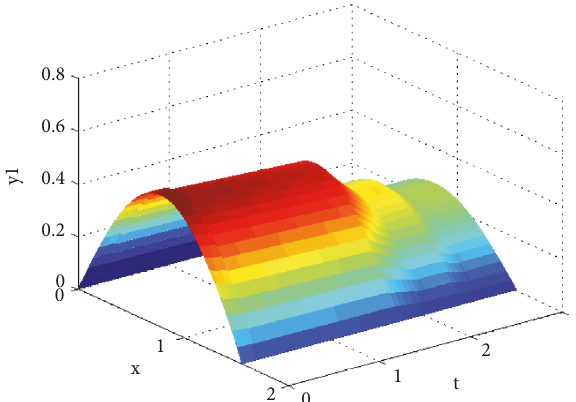
Figure 4: The trajectory of switching